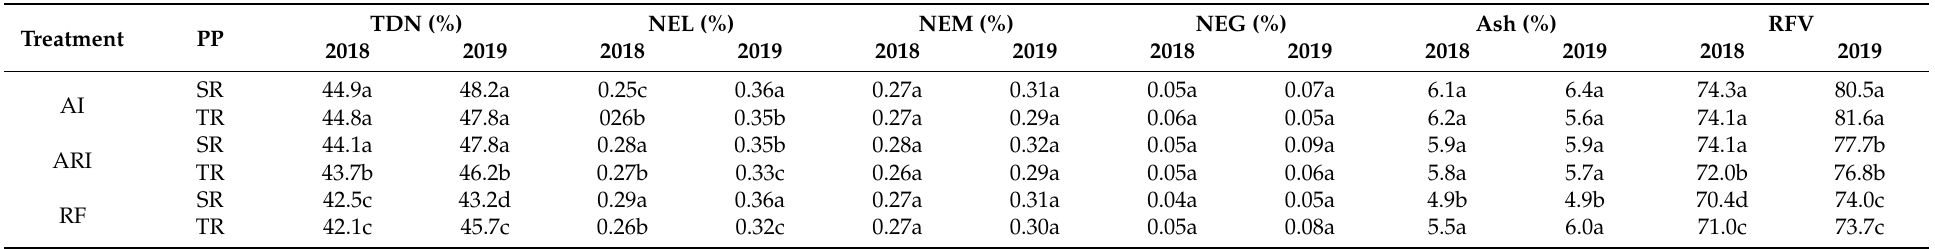
Table 3. Effect of irrigation treatments (AI, all row irrigation, ARI, alternate row irrigation, and RF, rainfed) and planting pattern (SR, single-row and TR, twin-row) on soybean biomass quality traits. PP is planting pattern, AI is all-row irrigation, ARI is alternate row irrigation, and RF is rainfed.